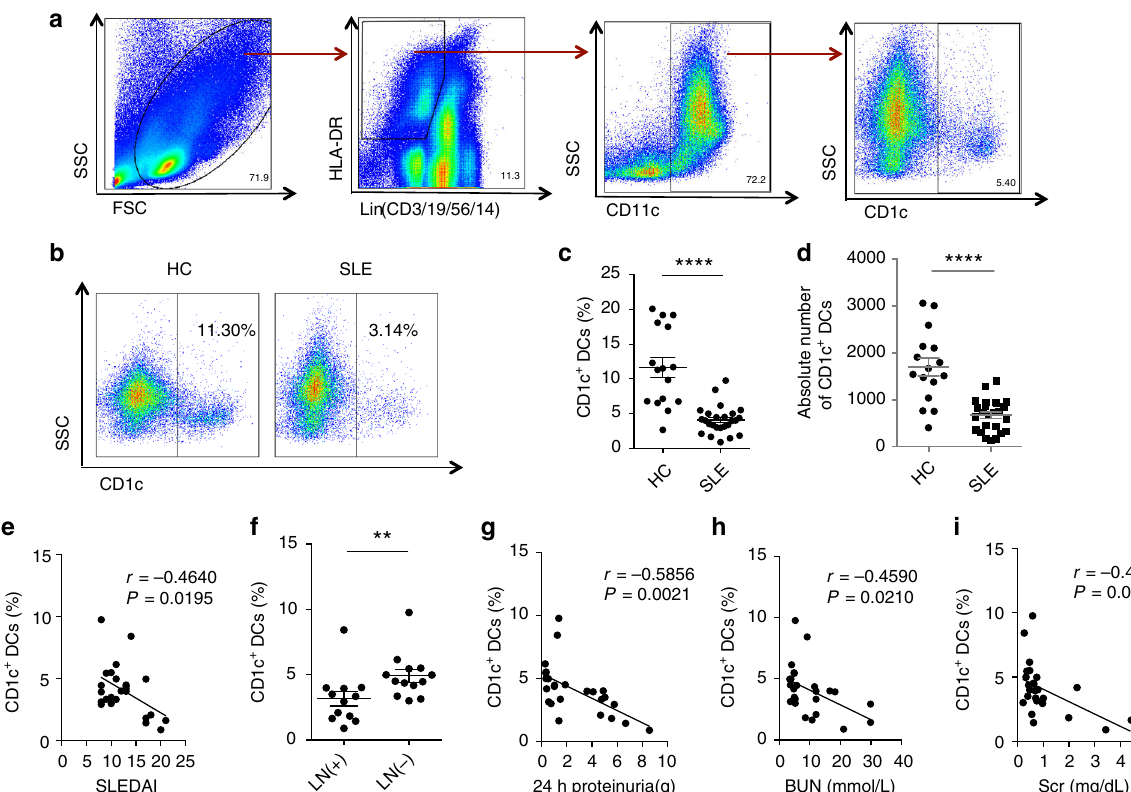
Fig. 1 CD1c + DCs decrease in patients with SLE. a FACS gating strategy used to identify CD1c + DCs, which were de fi ned as Lin(CD3/19/56/14) − HLA-DR + CD11c + CD1c + . b Flow cytometry analyses of CD1c + DCs in PBMCs between SLE patients ( n = 25) and healthy controls (HC) ( n = 16). c , d Quanti fi cation of CD1c + DCs in (b). e The correlation between the frequency of CD1c + DCs and systemic lupus erythematosus disease activity index (SLEDAI) score was analyzed by Pearson ’ s correlation coef fi cient ( n = 25). f The percentage of CD1c + DCs was compared between SLE patients with lupus nephritis (LN) ( n = 12) and without ( n = 13). g The correlation between the frequency of CD1c + DCs and the level of 24 h proteinuria was analyzed by Pearson ’ s correlation coef fi cient ( n = 25). h The correlation between the frequency of CD1c + DCs and the level of blood urea nitrogen (BUN) was analyzed by Pearson ’ s correlation coef fi cient ( n = 25). i The correlation between the frequency of CD1c + DCs and the level of serum creatinine (Scr) was analyzed by Pearson ’ s correlation coef fi cient ( n = 25). The experiments were repeated ≥ 3 times (** p < 0.01, **** p < 0.0001, by t -test), SEM. Source data were provided as a Source Data fi